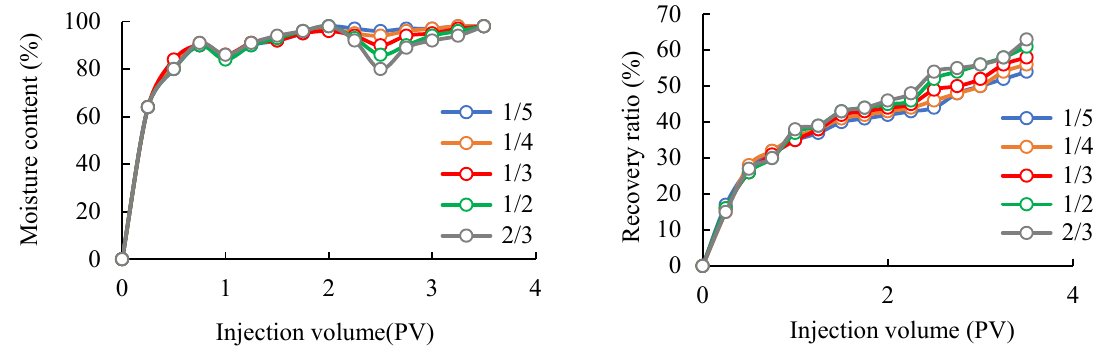
Figure 8. Oil displacement characteristic curves of different profile control radii.